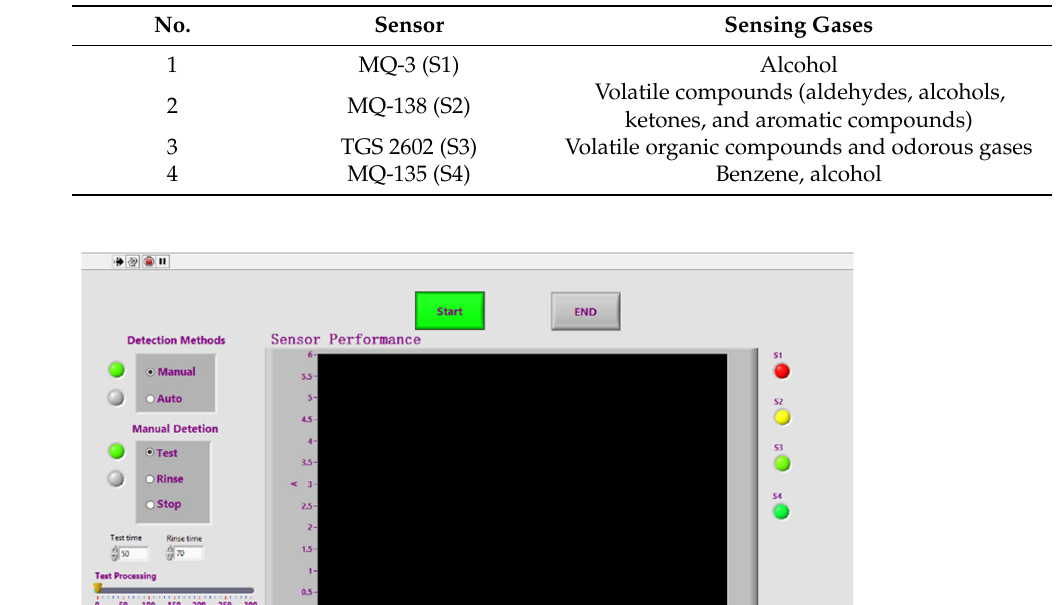
Figure 3. Illustration of tomato plant detection using the E-nose system.